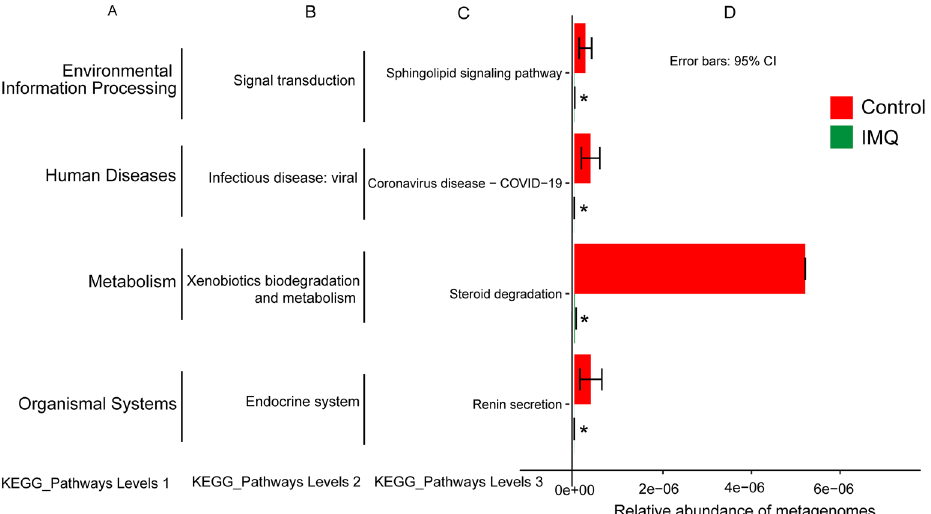
Figure 7. Relative abundance of KEGG pathways of functional categories in the skin microbiota. Functional predictions of the skin microbiota between the control group and IMQ group. Significant differences of KEGG pathways at level 3 were detected using STAMP software based on the KEGG pathway database (www. kegg. jp/ kegg1. html). * P <